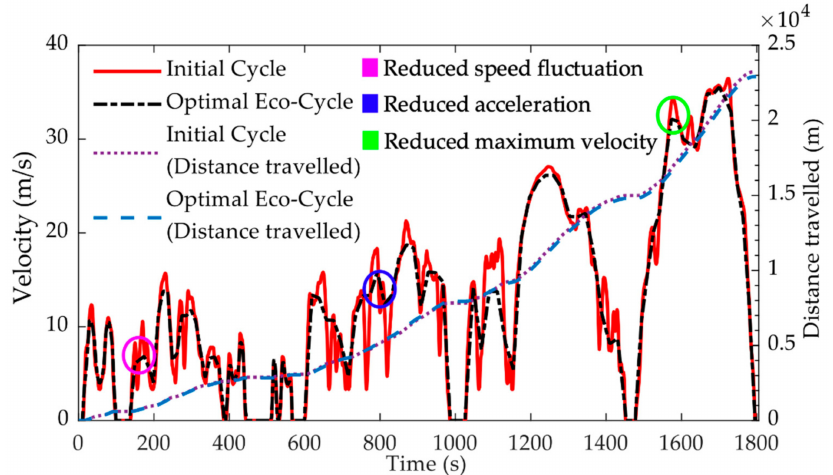
Figure 7. Optimized speed trajectory for the Worldwide Harmonized Light Vehicles Test Cycles (WLTC)—Class3b ( β =